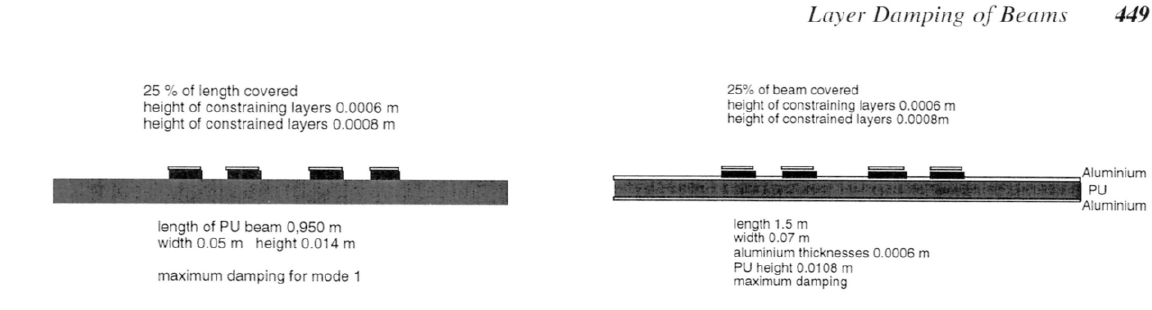
FIGURE 4 Maximum damping solution for PU beam.